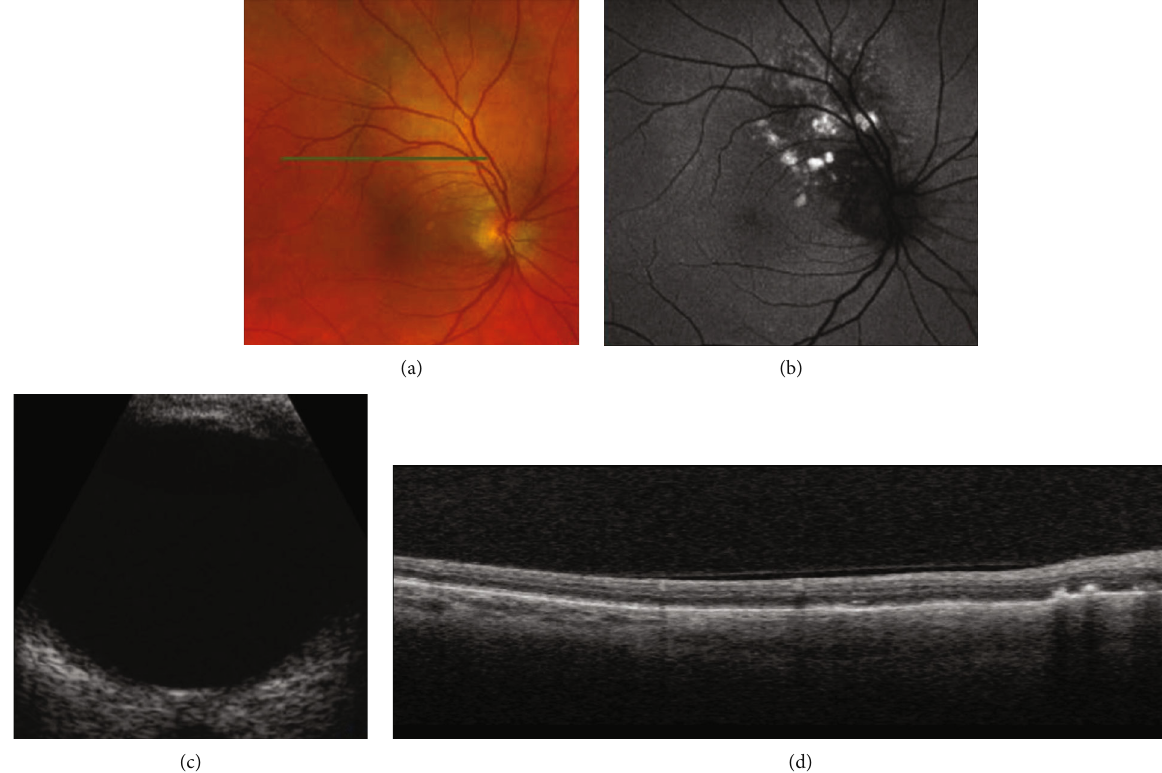
Figure 3: Right eye at one-month follow-up. (a) Fundus photograph showing resolution of choroidal mass with disappearance of subretinal fl uid around the lesion (b) corresponding auto fl uorescence image; (c) B-scan showing reduction in lesion thickness and (d) optical coherence tomography demonstrating resolution of exudative retinal